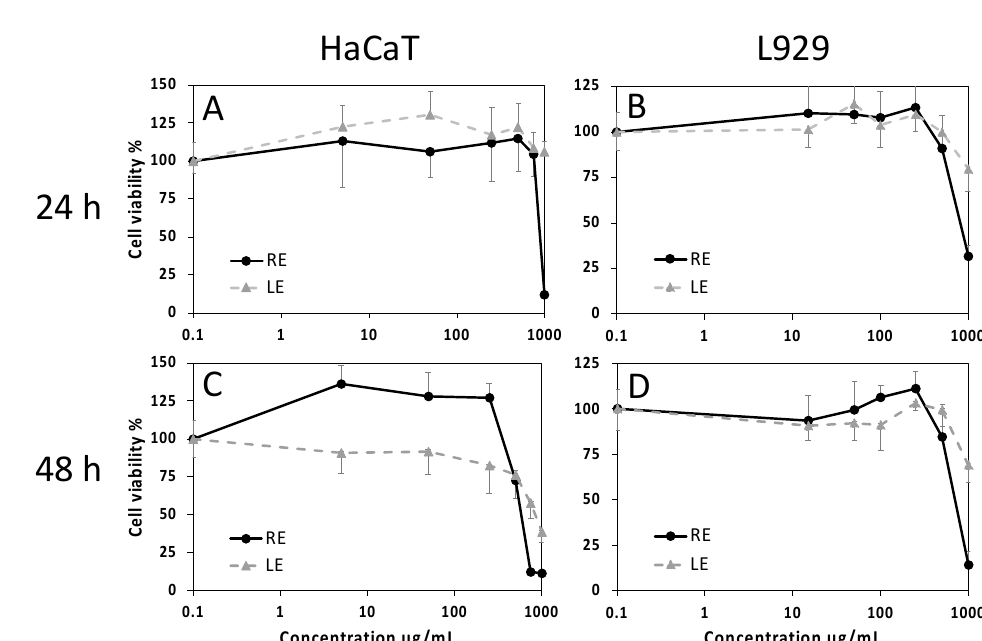
Figure 4. Cell viability evaluated by the MTT assay on HaCaT human keratinocytes ( A , C ) and L929 mouse fibroblasts ( B , D ) exposed for 24 h ( A , B ) or 48 h ( C , D ) to increasing concentrations of LE or RE. Data are mean absorbances ± S.D. of 570 nm readings, obtained from 6 replicate wells for each condition in two independent experiments. Values of IC 50 and IC 05 at 48 h are reported in Table 5. Table 5. Median (IC 50 ) and threshold (IC 05 ) concentrations of LE and RE on HaCaT human keratinocytes and L929 mouse fibroblasts evaluated by the MTT assay at 48 h endpoints. Leaf Extract